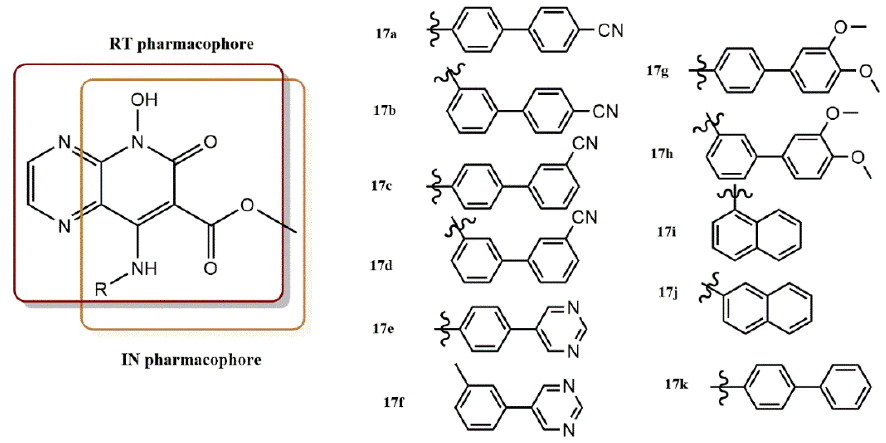
Figure 18. RT and IN pharmacophores of new active synthesized compounds 17a-k .